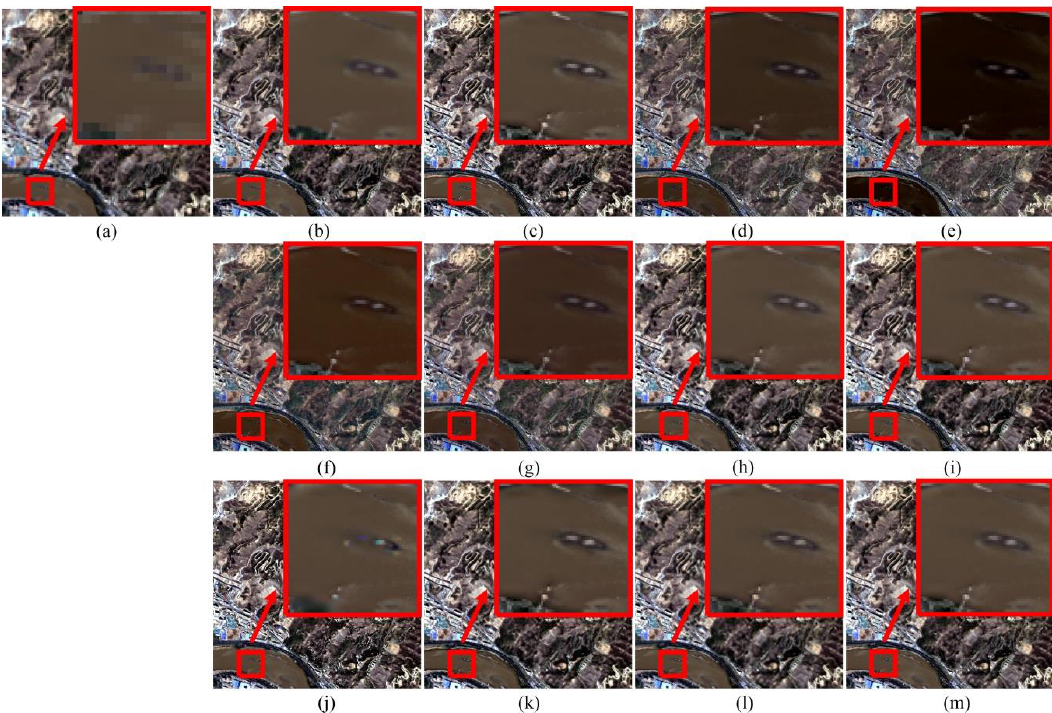
Figure 13. Pansharpening results of Lanzhou dataset. ( a ) MS. ( b ) Ground-truth image. ( c ) PPCNN. ( d )